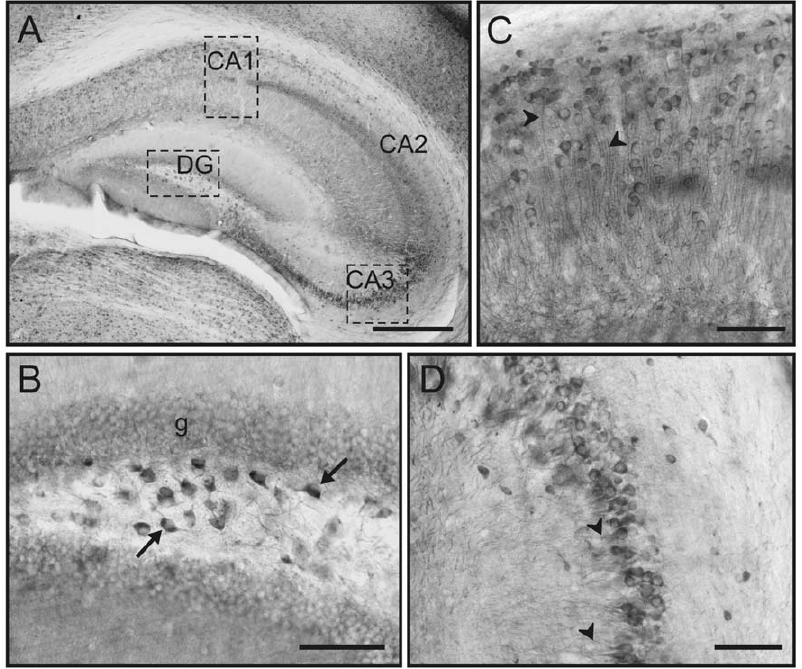
Figure 2. GSK3 b labeling in the hippocampus. A) Low magnification image showing GSK3 b labeling in different layers of the hippocampus. This immunolabeling is especially robust in the Cornu Amonis (CA) subfields and in the dentate gyrus (DG). B) Detail of the dentate gyrus showing labeling in the neurons of the polymorphic layer (arrows) and also in the granular layer (g). C–D) Detail of GSK3 b immunolabeling in pyramidal cells of CA1 ( C ) and CA3 ( D ) and in their processes (arrowheads). [Scale bars: 400 m m in A; 100 m m in B–D]